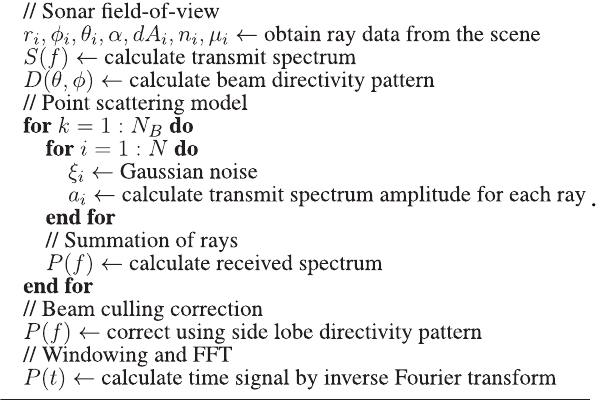
Algorithm 1 Multibeam echosounder calculation